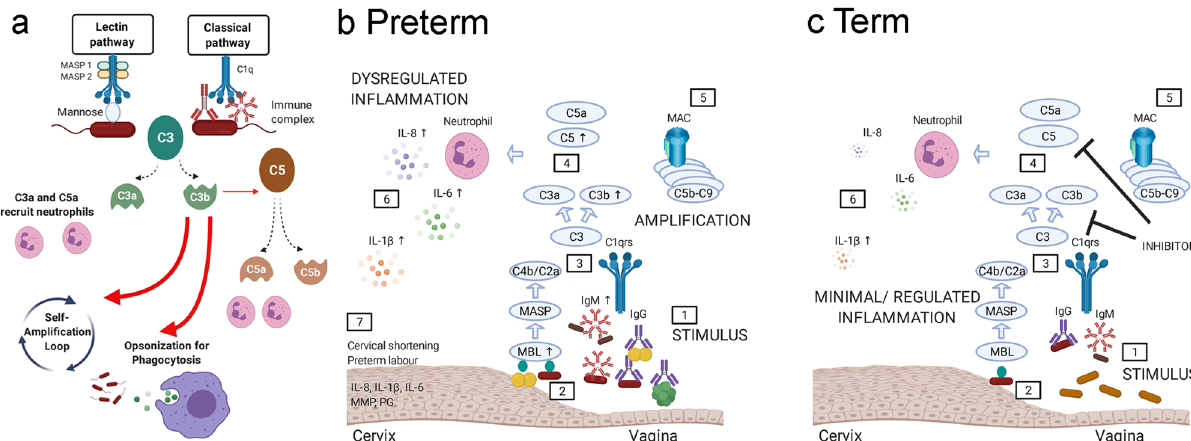
Fig. 10 Proposed mechanism for microbial-driven preterm birth. The complement system is an integral component of the immune response and bridges the adaptive and innate response to pathogens. MBL activates the lectin pathway, whereas IgM and IgG1-3 complexes activate the classical pathway ( a ). Both pathways converge on the central component C3, which is activated via C3 convertase. Upon activation C3 is cleaved to generate C3b and C3a.C3b binds to C3 convertase to form C5 convertase, which leads to release of C5b and C5a.C3a and the more potent C5a lead to increased vascular permeability and chemoattract phagocytes, and C3b opsonises pathogens and aids phagocytosis via C3b receptors. The alternative pathway also activates a positive feed forward ampli fi cation loop via C3b deposition on the surface of pathogens. We propose that in women who deliver preterm, CST III ( L. iners ) and CST IV (diverse species) activate the complement cascade, which leads to a local pro-in fl ammatory immune milieu. It is likely that the presence of activated neutrophils leads to an increase in the local concentration of IL-8, IL-6, and IL-1 β , prostaglandins (PGs) and matrix metalloproteinases (MMPs). If a dysregulated response occurs, this may lead to cervical shortening and preterm labour ( b ). In women who deliver at term ( c ), there is a predominance of CST I ( L. crispatus ). However, if CST III ( L. iners ) or CST IV (diverse species) is seen, we propose that a more regulated immune response prevents cervical shortening and the triggering of early parturition. Figure created with